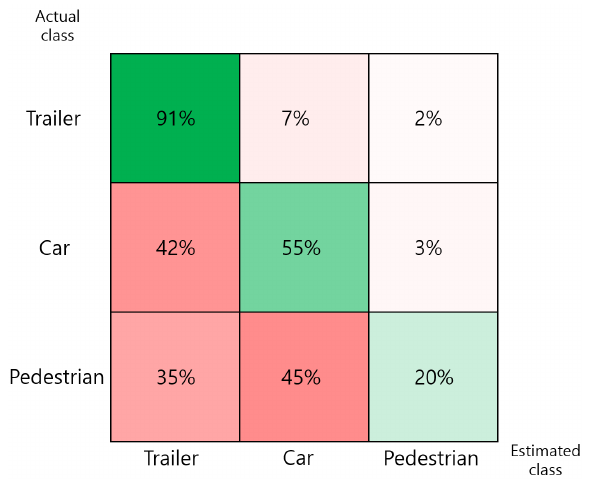
Figure 11. Classification results of the conventional